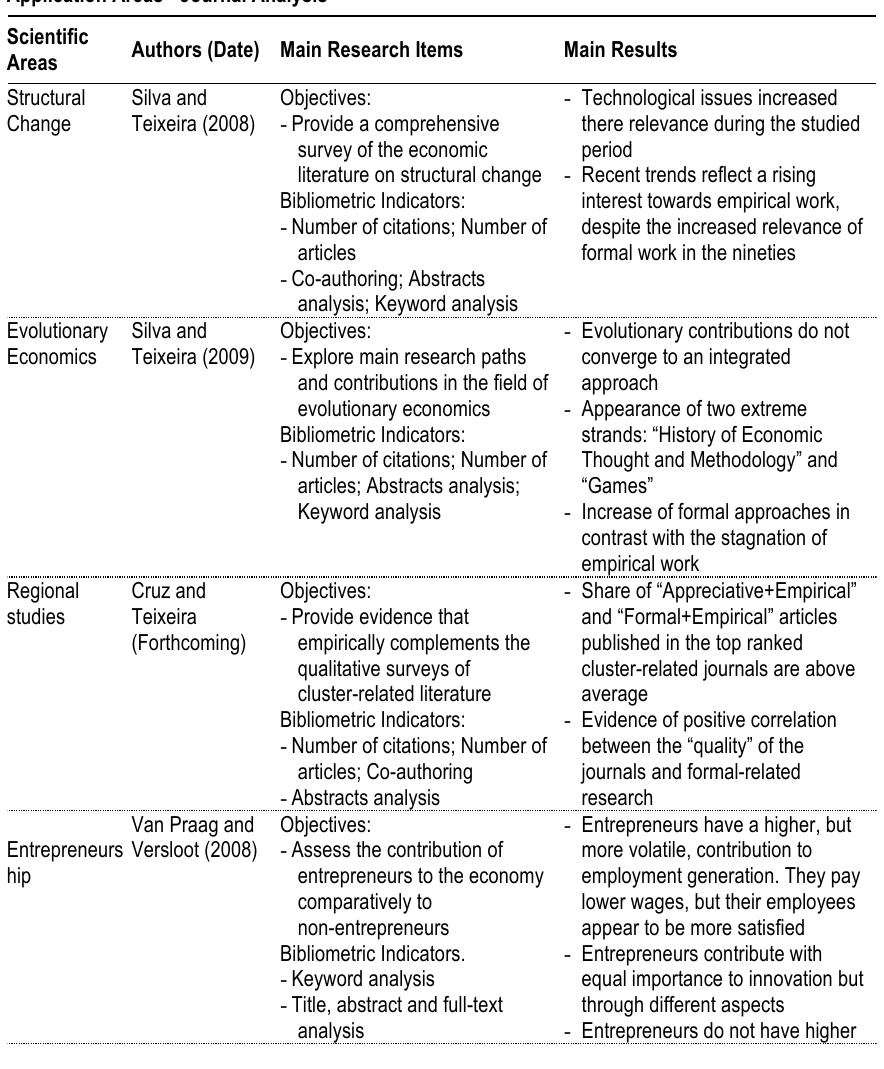
Table A1b : Bibliometric studies – Themes categorizations Application Areas - Journal